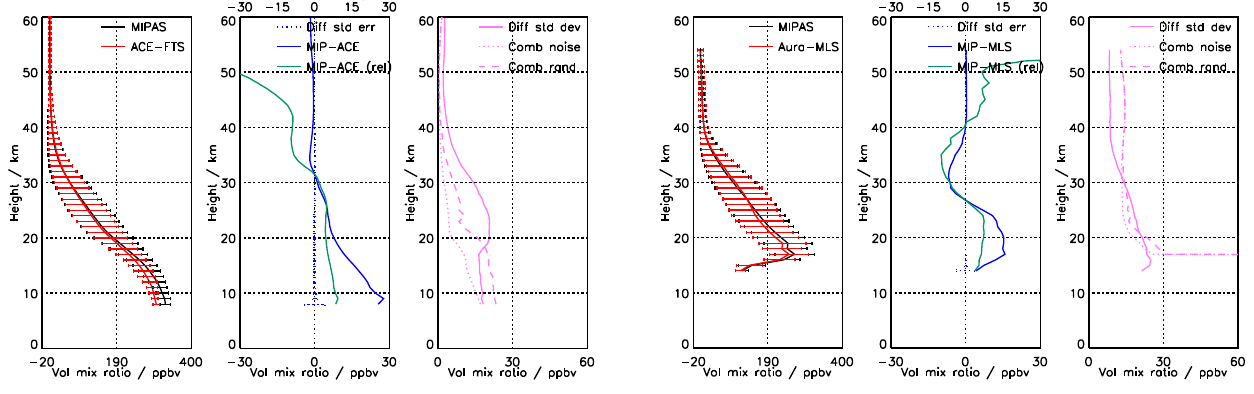
Figure 5. Comparison of N 2 O from ACE-FTS and MIPAS re- duced resolution (V5R_N2O_224 and V5R_N2O_225). Details as in Fig. 1.